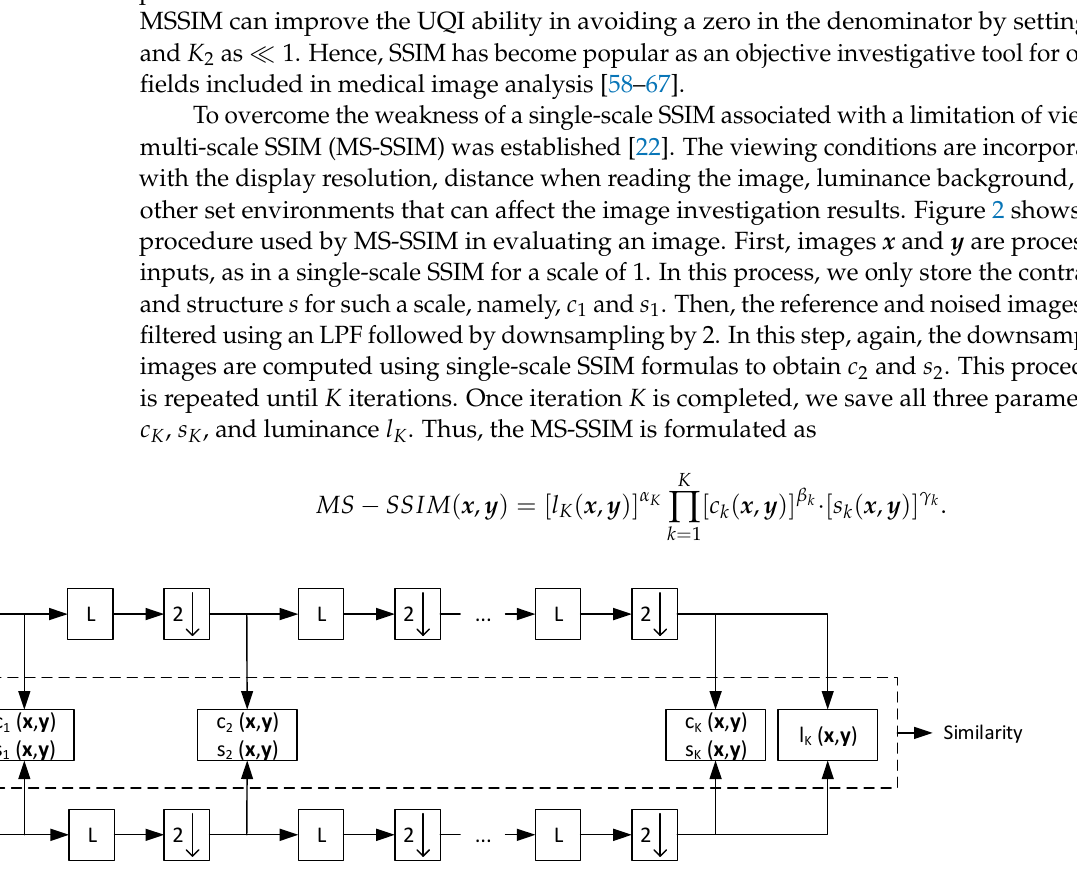
Figure 2. MS-SSIM procedures to quantify the image quality (adapted from [22]). 𝐿 is low-pass filtering, and 2 ↓ denotes downsampling by 2 .